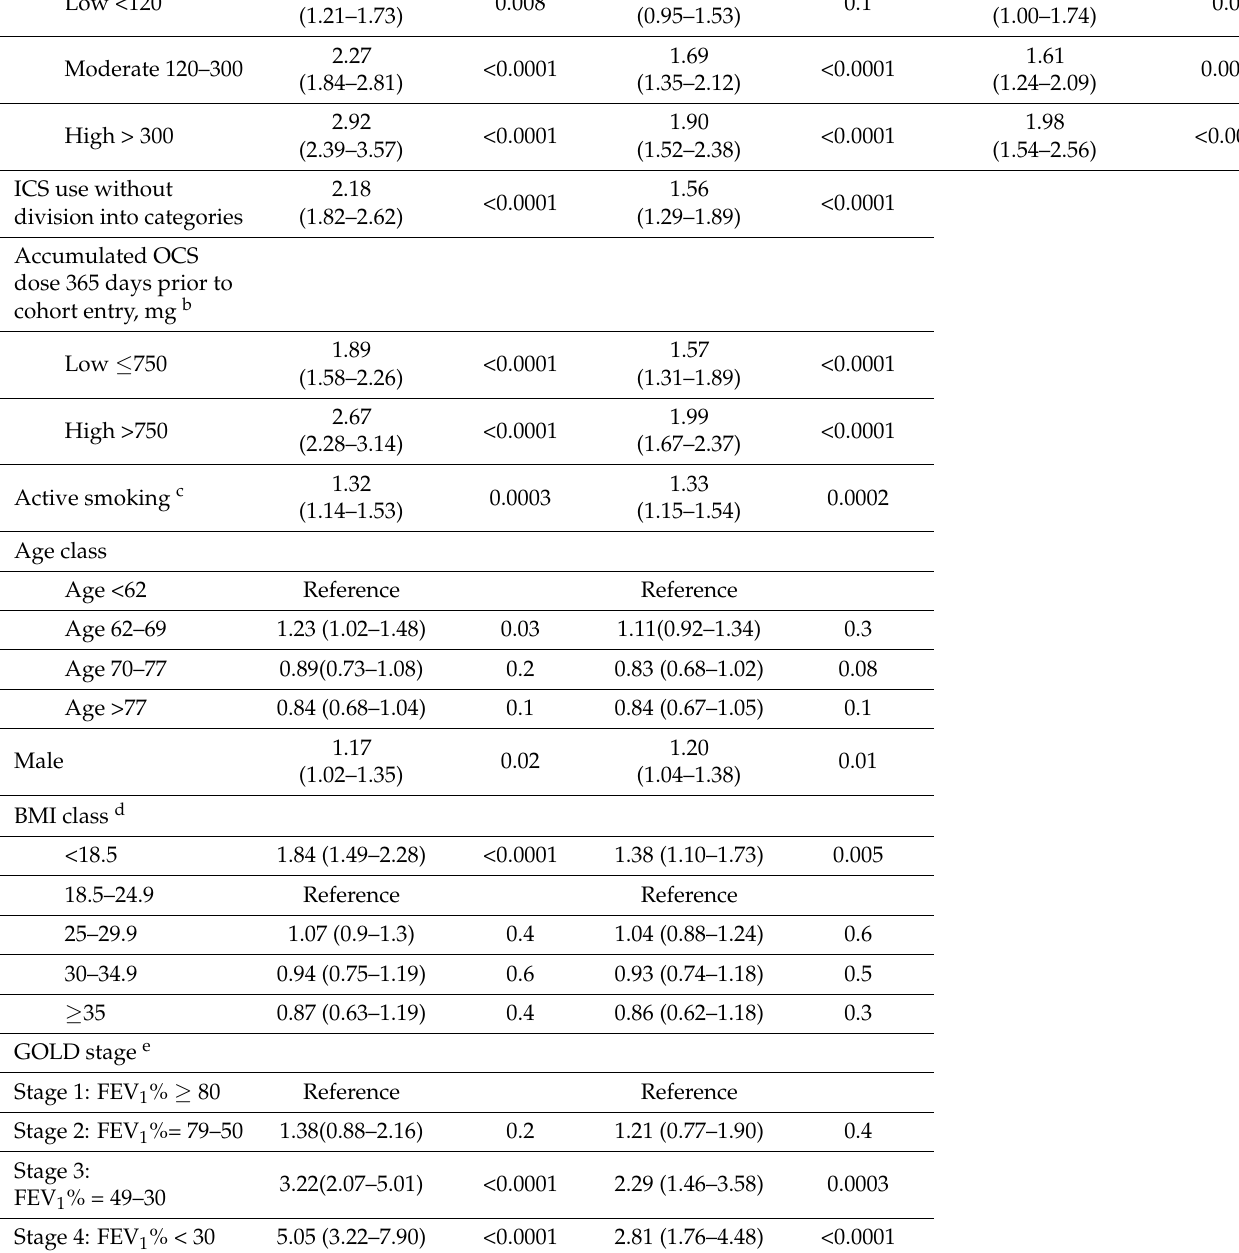
variables displayed in the table. a Reference: no ICS use. b Reference: no OCS use. c Reference: never or